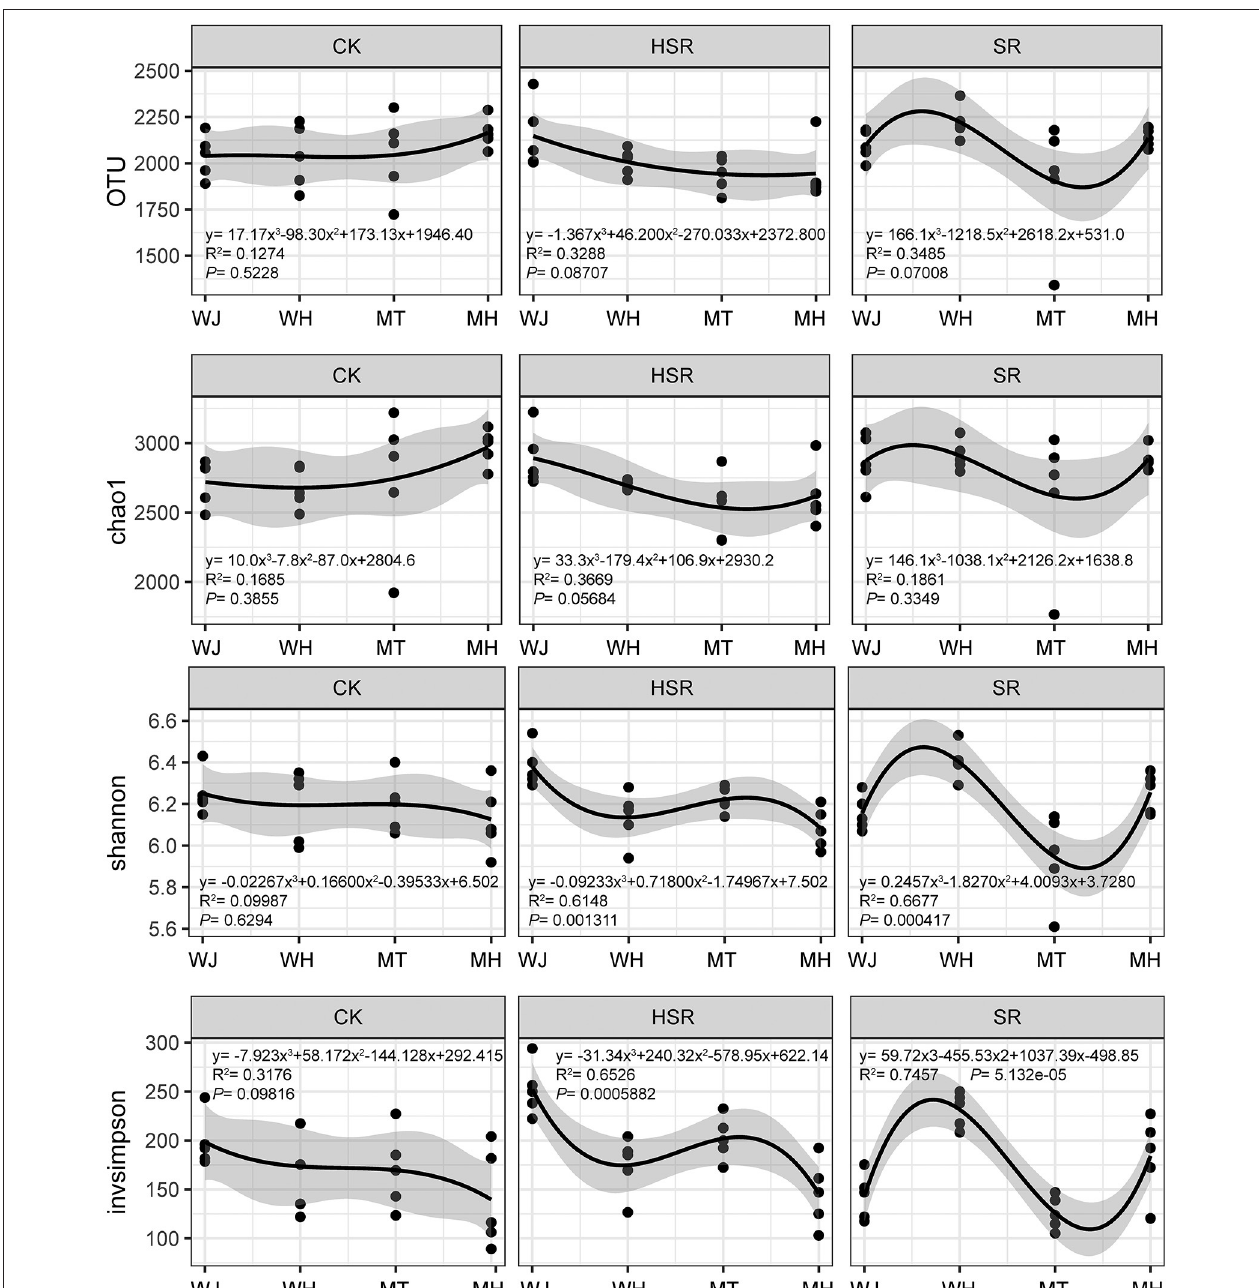
FIGURE 1 | Effect of different amounts of corn straw returned to the field on the alpha diversity of soil bacteria. WJ, the jointing stage of the wheat season; WH, the harvesting stage of the wheat season; MT, the tasseling stage of the corn season; MH, the maturity stage of the corn season.